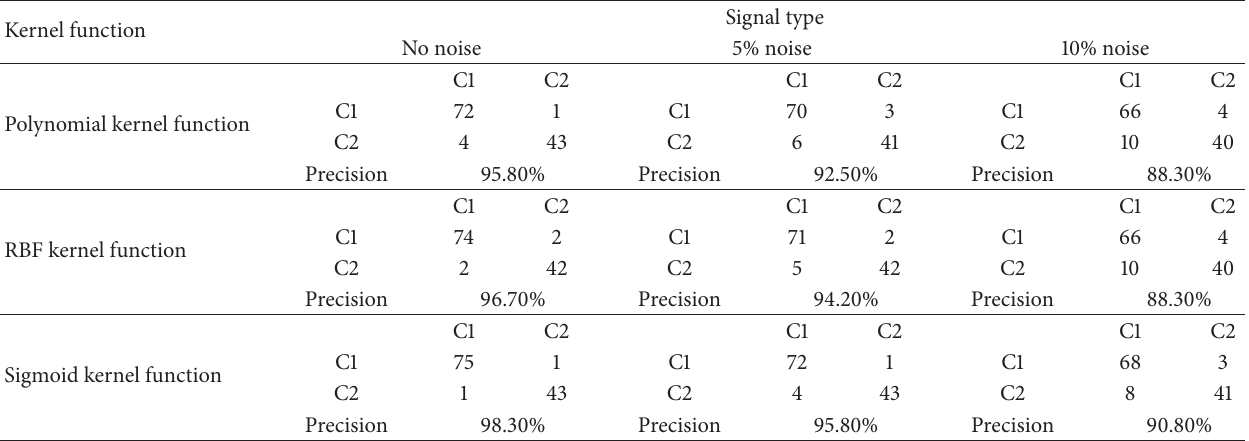
Table 1: Testing result of 16-machine 68-bus benchmark system.